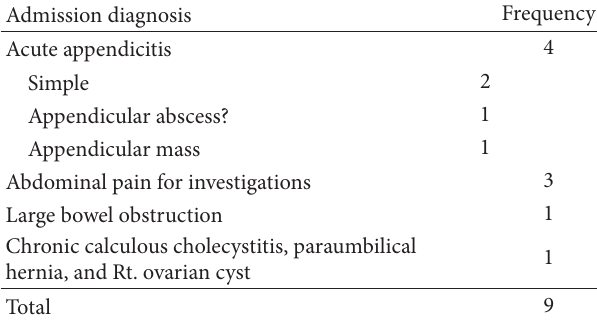
Table 2: Admission diagnosis and its